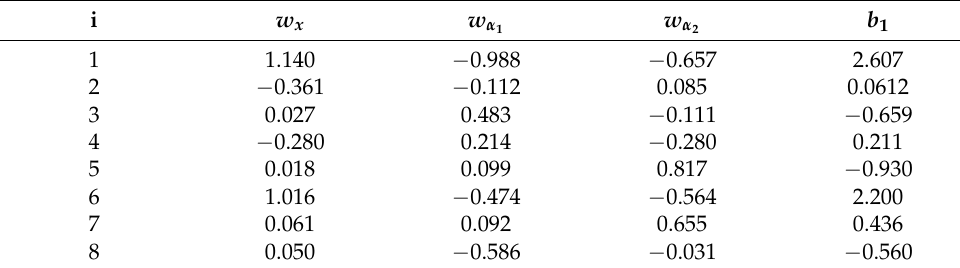
Table 7. Constant values of weights and bias for hidden layer.